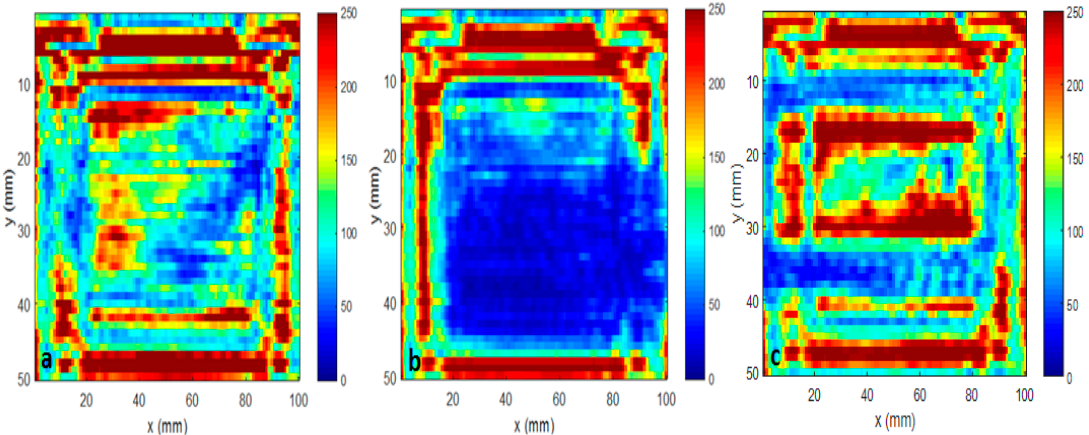
Figure 4. Images of transmitted amplitude information acquired from the mm-wave line scanner imager at 100 GHz: ( a ) printed silver ink on a Teslin paper substrate without rolling compression treatment after printing; ( b ) printed silver ink on Teslin paper substrate with rolling compression treatment after printing; ( c ) printed silver interdigital electrode ink on a thin polyethylene film substrate. The hot red color indicates higher amplitude mm-wave signals transmitted through the samples and the dark blue denotes lower amplitude signals transmitted through the samples.